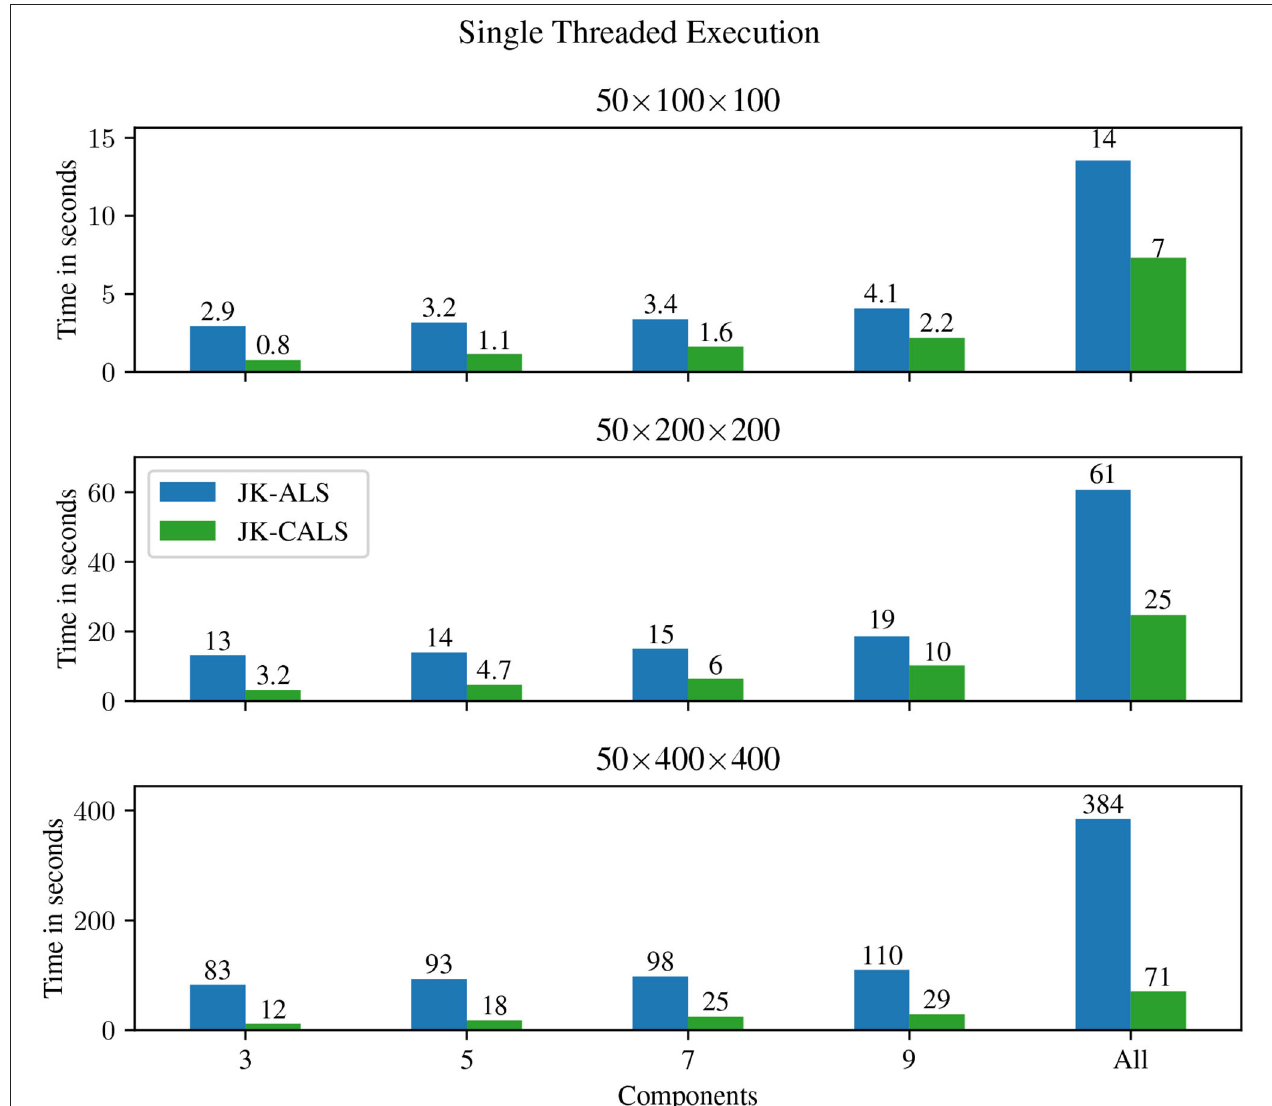
FIGURE 2 | Execution time for single-threaded jackknife resampling applied to three different tensors (small, medium, and large in the top, middle, and bottom panels, respectively), and different number of components (from left to right: R ∈ { 3,5,7,9 } , and “All,” which represents doing jackknife to all four models